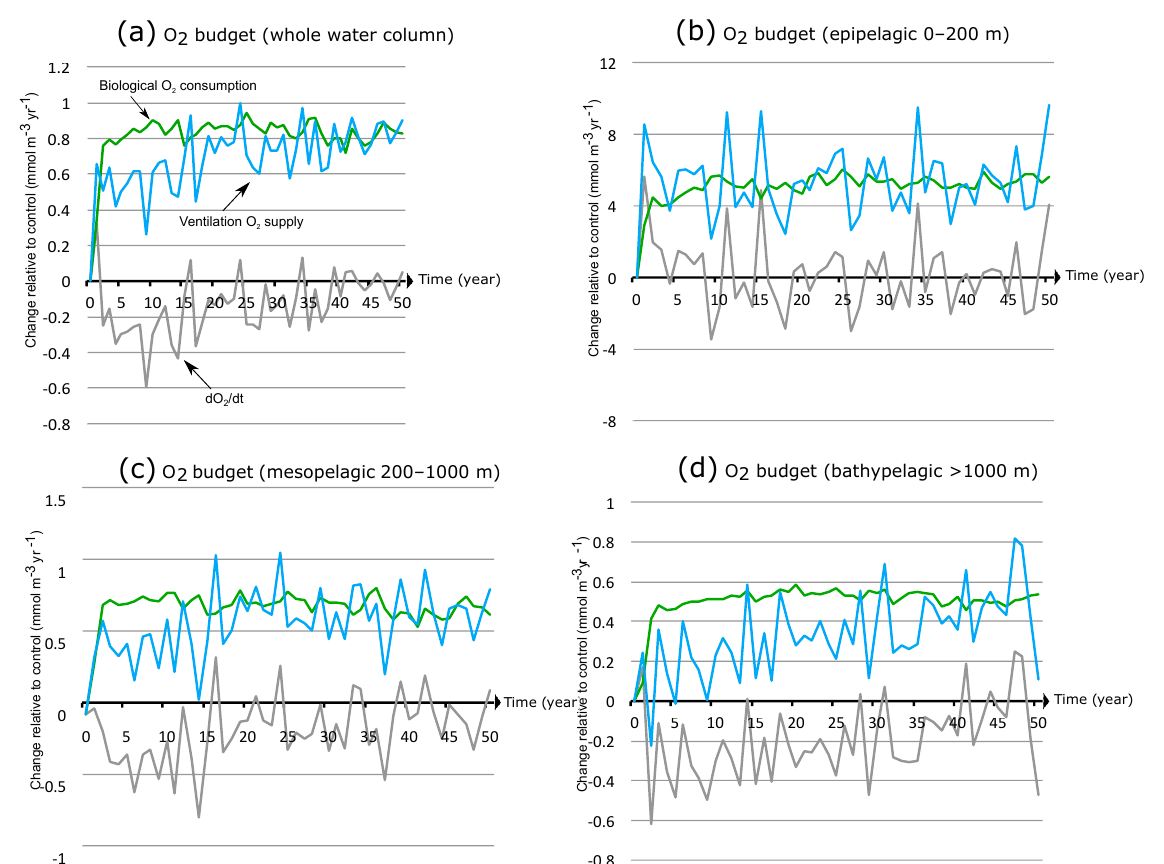
Figure 9. Drivers of OMZ expansion under monsoon intensification. Annual O 2 accumulation (tendency dO 2 ( + 50%) relative to control (grey line) and its biological (green) and physical (blue) sources in the OMZ as a function of time in (a) the whole water column, (b) the epipelagic zone (0–200m), (c) the mesopelagic zone (200–1000m) and (d) the bathypelagic zone ( > 1000m).